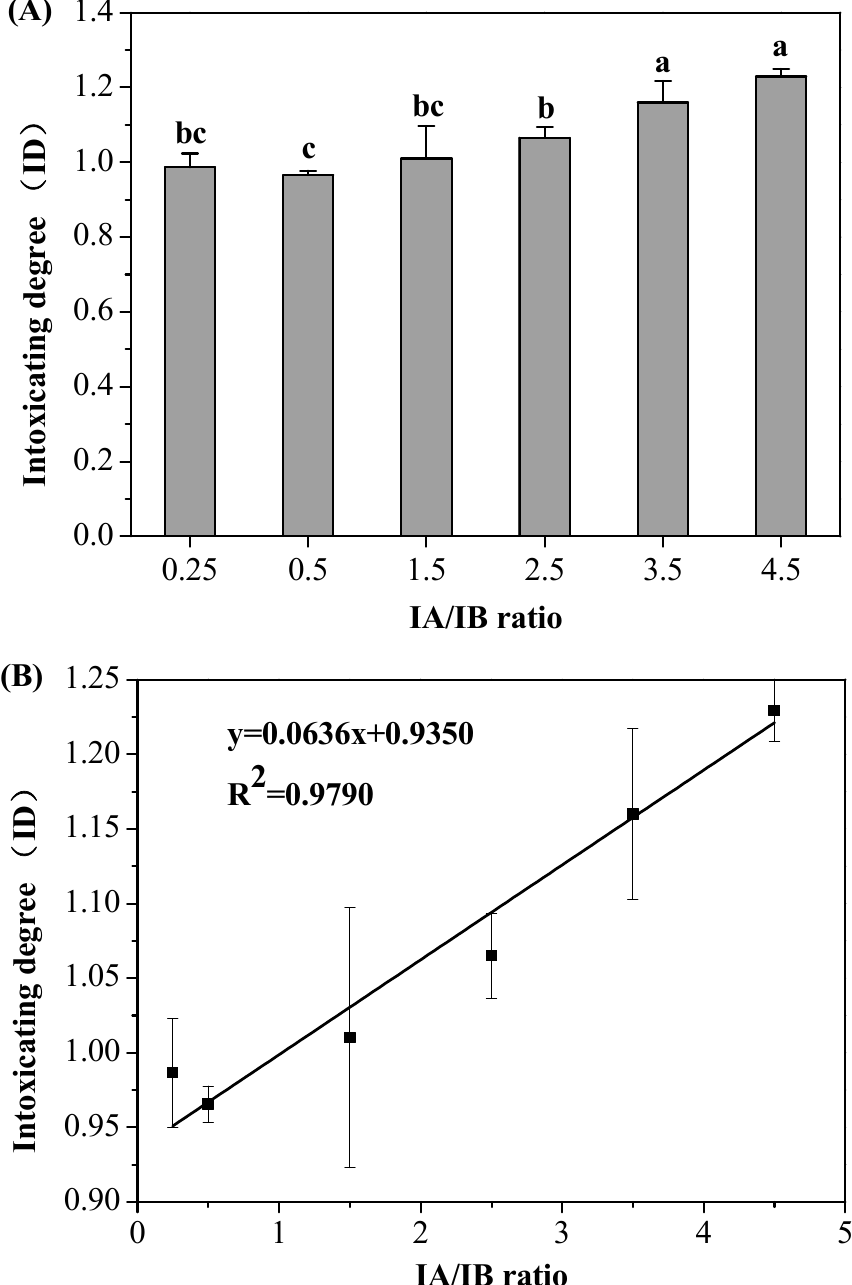
Figure 2. ( A ) The effects of isoamyl alcohol to isobutanol (IA/IB) ratio on the intoxicating degree (ID) of formulated liquors (FLs); and ( B ) the relationship between the IA/IB ratio and ID. Each value is expressed as the mean ± standard deviation ( n = 3). Different letters (a, b, c) indicate significant differences in the IDs of FLs. IA: isoamyl alcohol; IB: isobutanol; IA/IB: isoamyl alcohol/isobutanol.